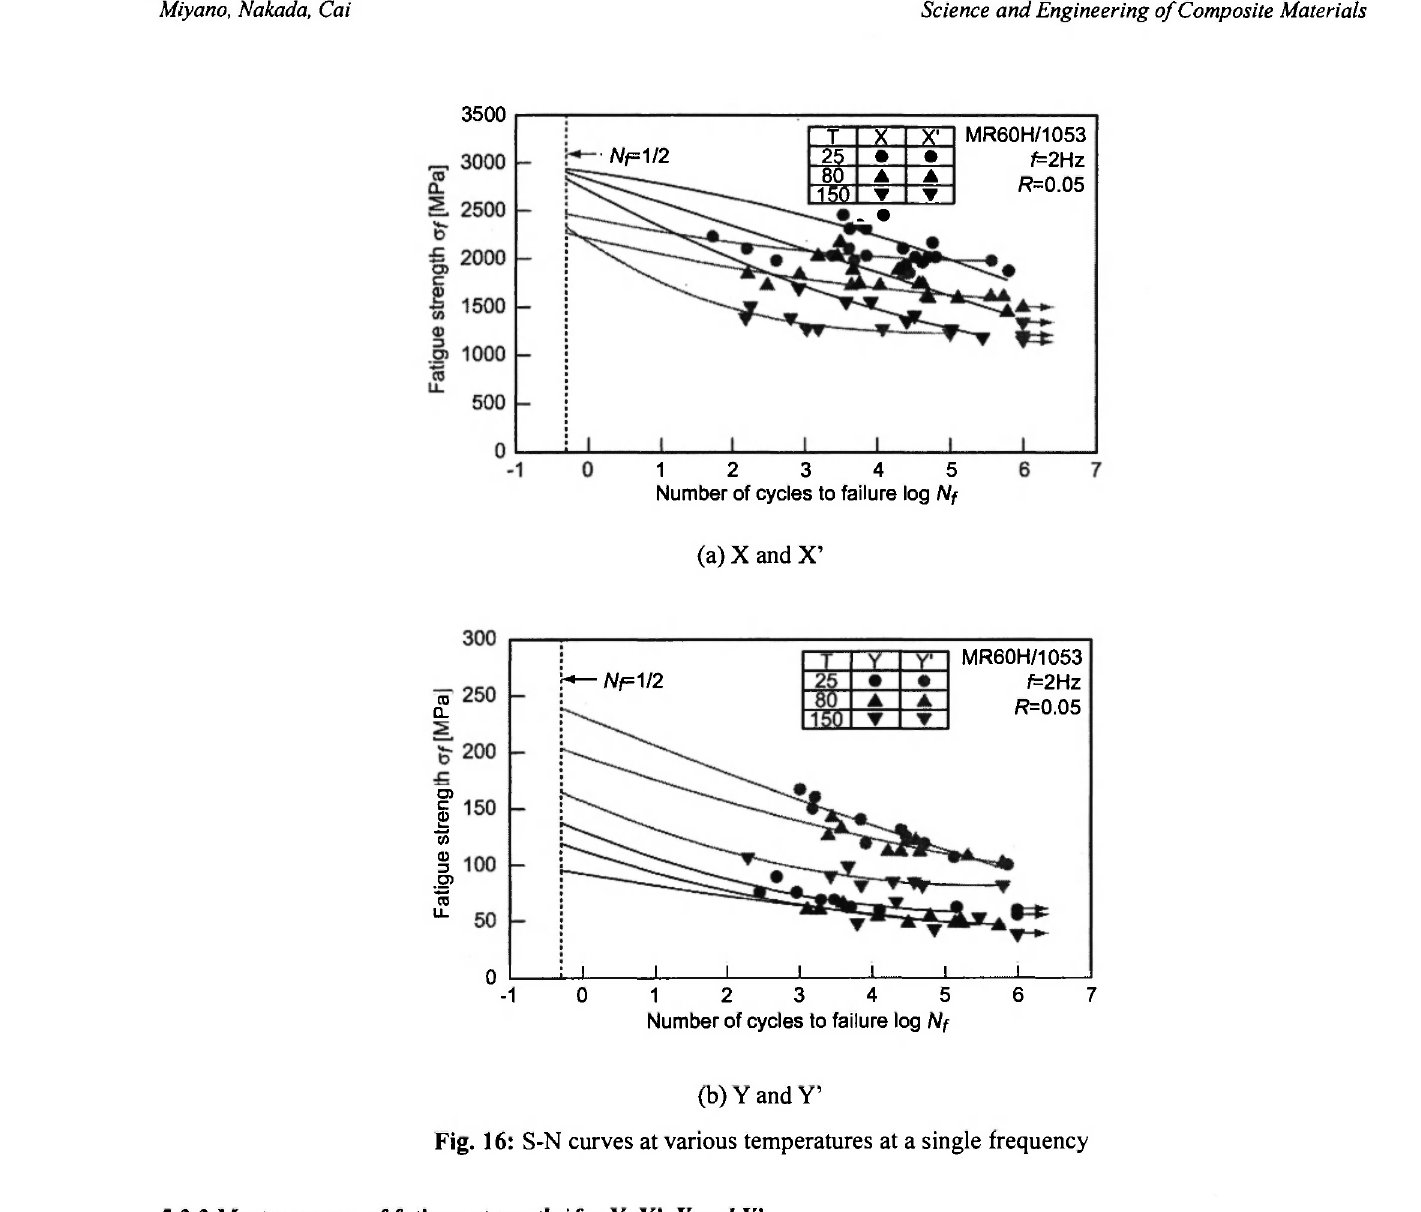
Fig. 16: S-N curves at various temperatures at a single